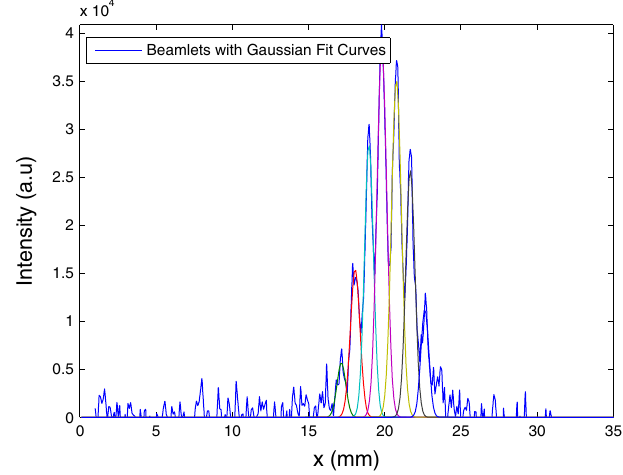
FIG. 6. Beam profile after the multislit mask, with Gaussian fit curves for individual